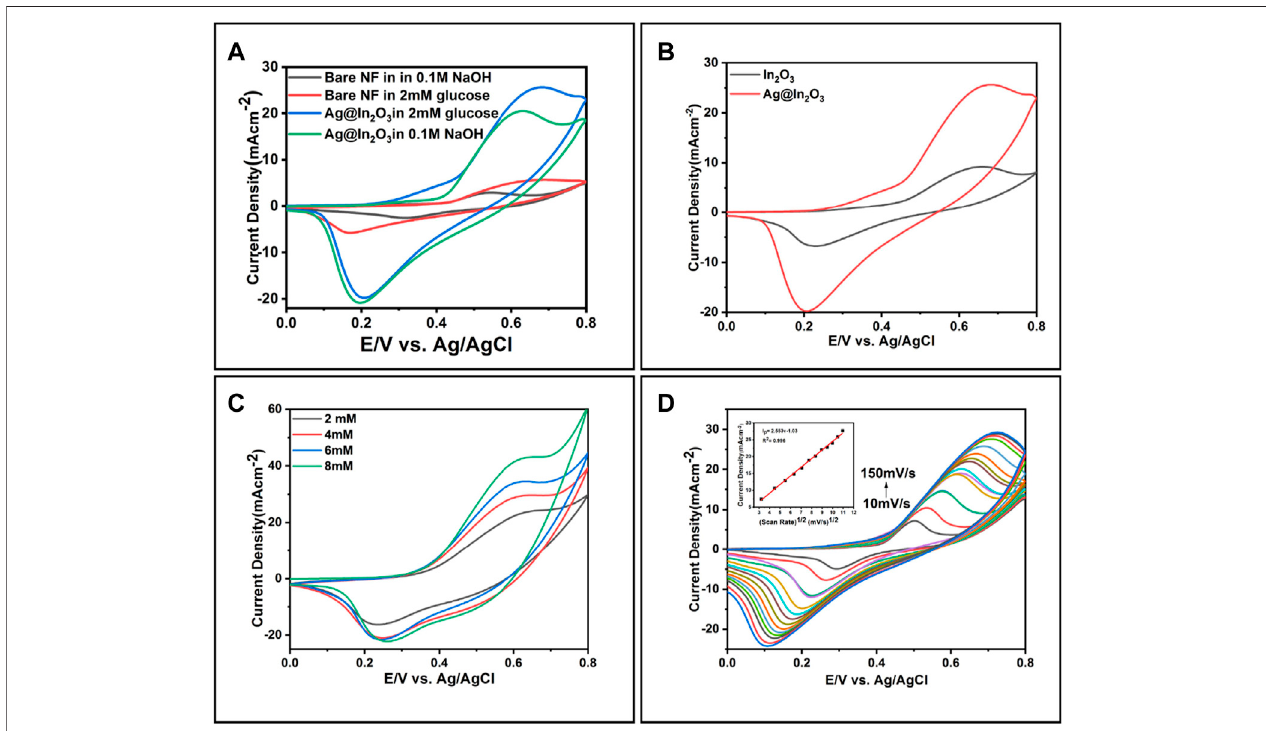
FIGURE6|(A) CyclicVoltammetryofbareNFandAg@In 2 O 3 in0.1 MNaOH,withandwithoutglucose (B) ComparisonbetweentheCVsofIn 2 O 3 andAg@In 2 O 3 in 2 mM glucose, (C) Response of Ag@In 2 O 3 modi fi ed NF after successive addition of 2 – 8 mM glucose, (D) CVs of Ag@In 2 O 3 in the presence of 2 mM glucose in the potential range of 0 V to +0.8 V at different scan rates of 10 – 150 mVs − 1 (Inset: the plot of Ip vs. v).